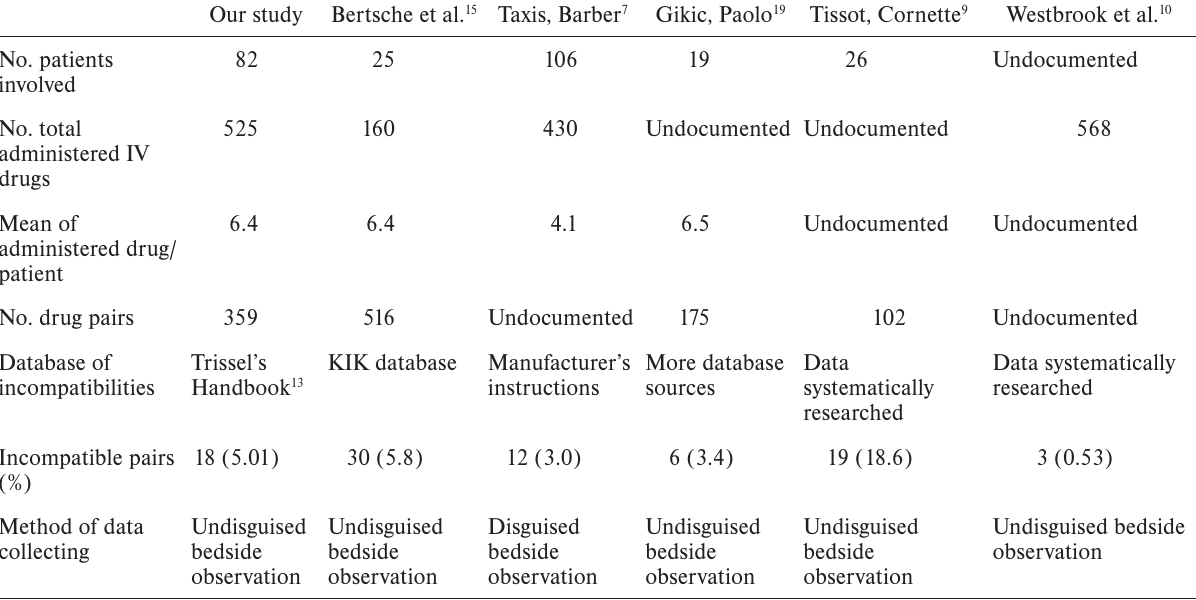
Table 3. Comparison of similar studies focused on intravenous